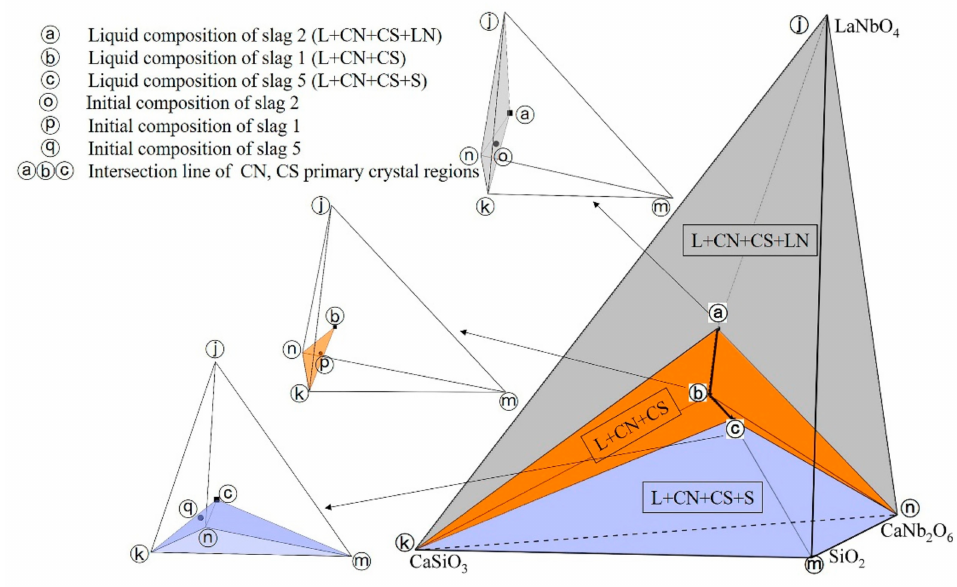
Figure 4. Intersection line of CN and CS primary crystal